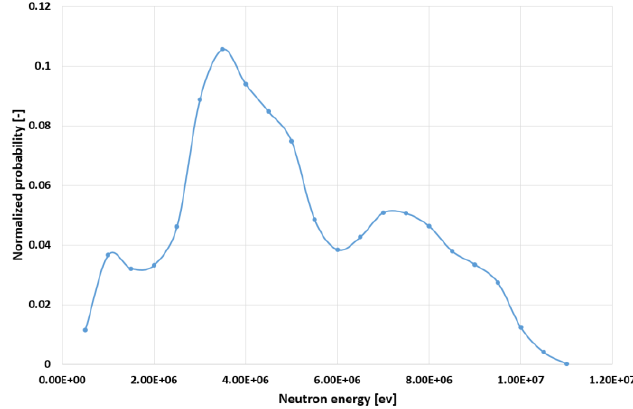
Fig. 2. PuBe neutron emission spectrum [6]